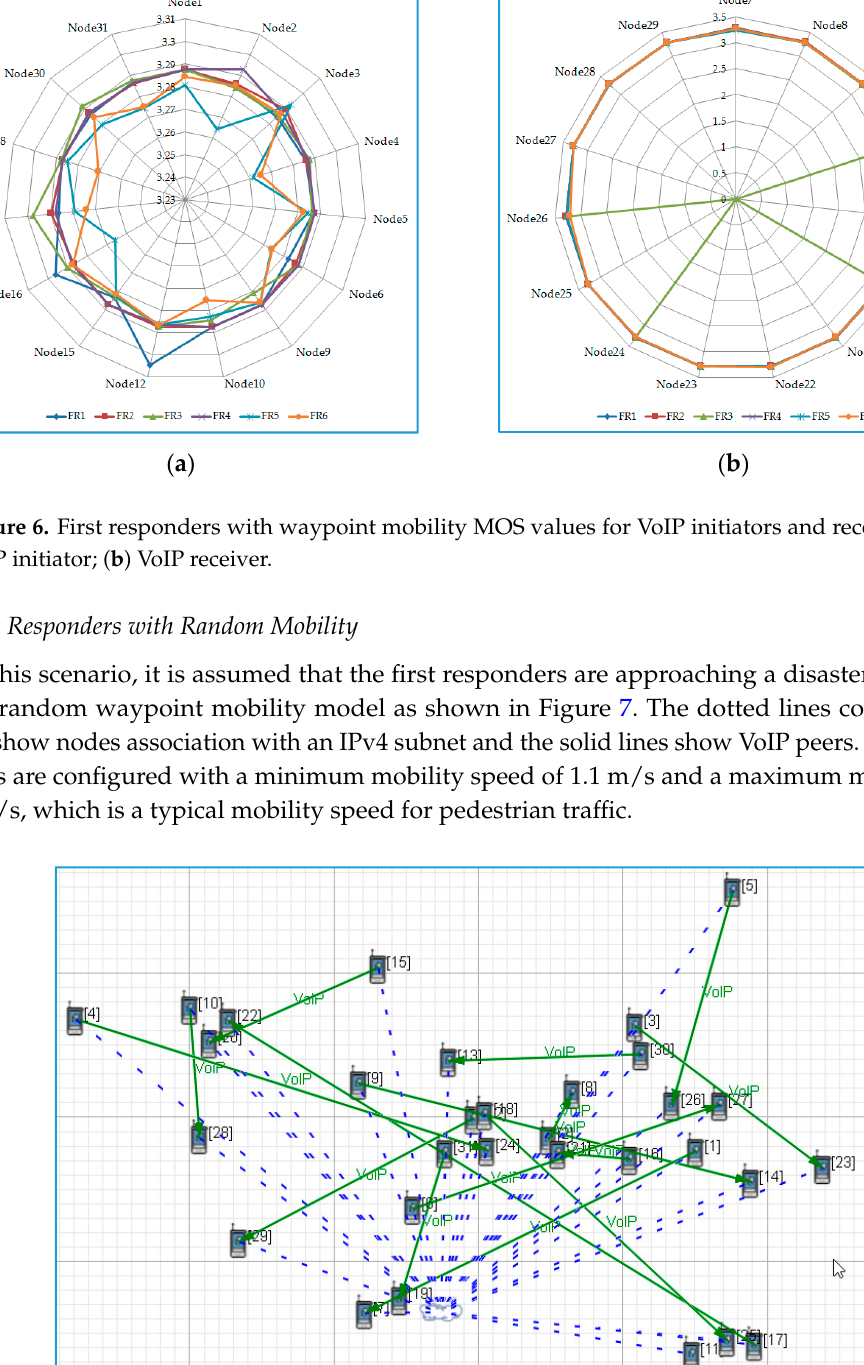
Figure 5. First responders with waypoint mobility. The flags with dotted lines show the positions to which the nodes move, the dotted lines connected to a cloud show the IPv4 subnet association. The solid lines show VoIP peers.